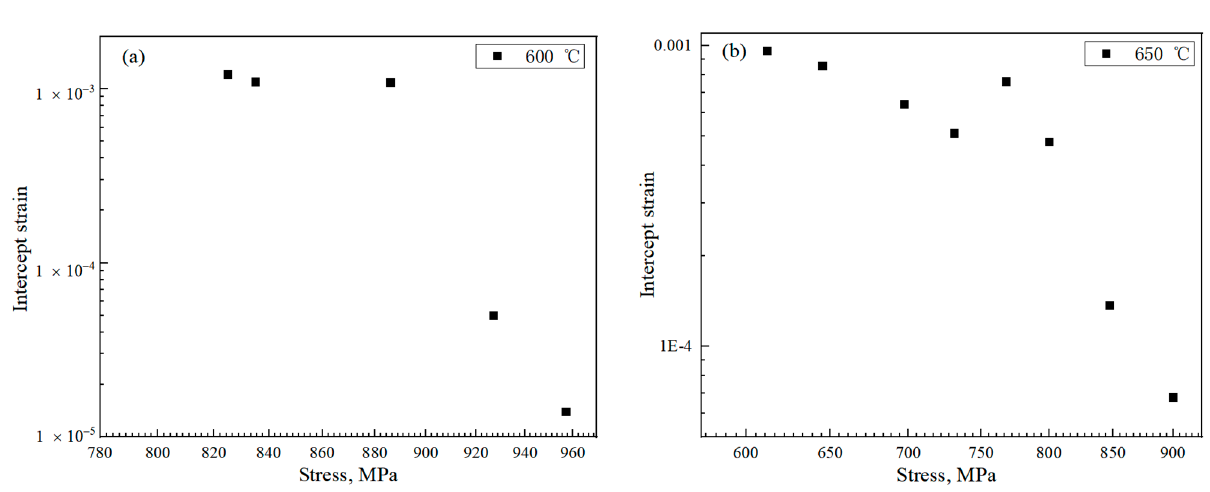
Figure 12. Relationship between intercept strain and stress: ( a ) at 600 °C; ( b ) at 650 °C.